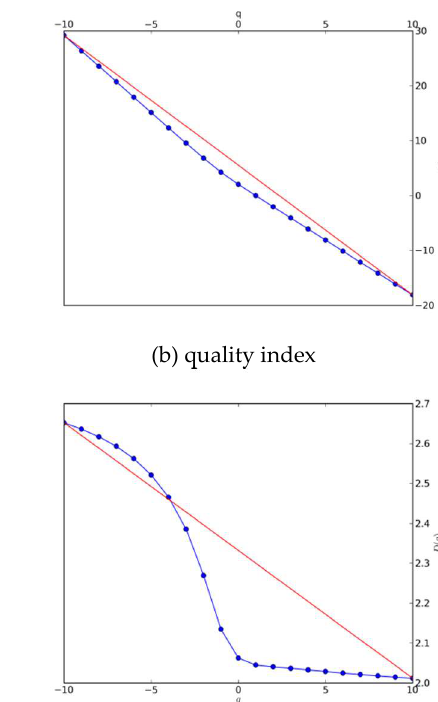
(b) convex function Figure 8. An abnormal phenomenon existed in the homogenized precipitation field of February 2015. ( a ) singularity exponent, ( b ) convex function. All downscaling methods were designed to enhance the heterogeneity of precipita- tion fields at a subpixel level in practice—in other words, to create reasonable and diverse precipitation intensity values within a 100 km 2 area—since the initial spatial resolution is 10 km. For the MFRC downscaling model, the sub-pixel heterogeneity is solely produced by the random variable X of the cascade generator, in that it always takes the mean values of multiple downscaled results because of the absolute randomness at any position. Unfortunately, a kind of self-contradiction that creates heterogeneity with X and av- erages the different results, so the number of times the cascade process is run is essential for the performance of the final model and the consumption of computing resources.